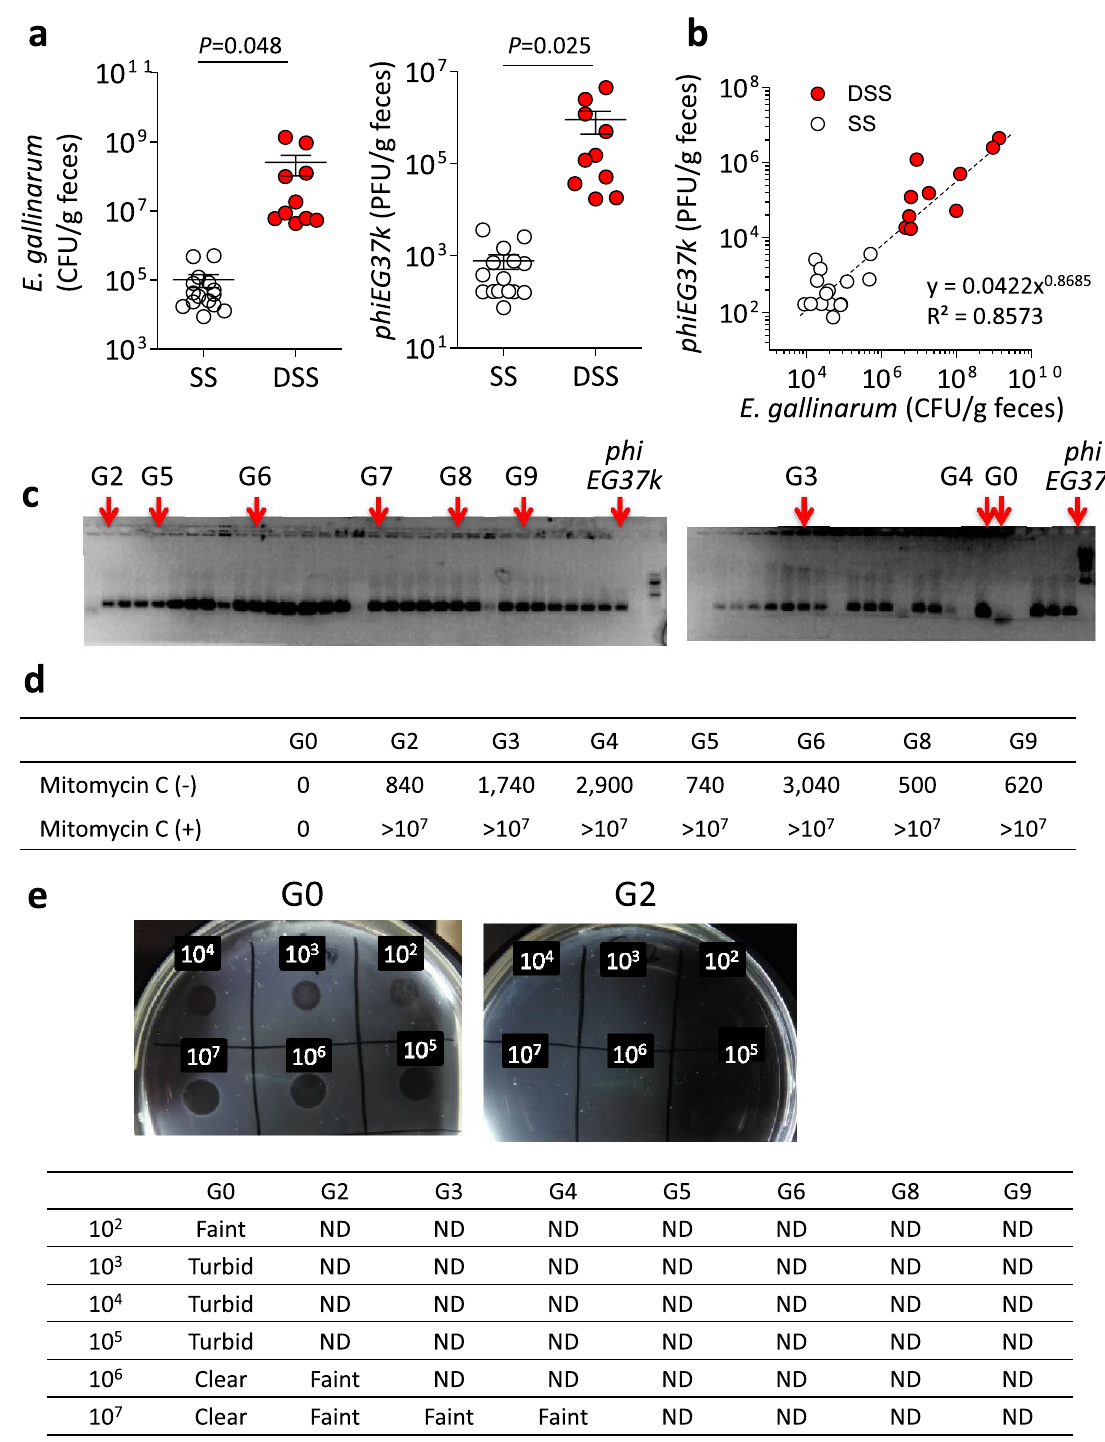
Figure 2. Most phiEG37k phages exist in lysogenic cycle in the colonic ecosystem in SPF C57BL/6 mice. The characterization of the interaction of phiEG37k phage and host E. gallinarum in the gut ecosystem was investigated . ( a ) Titers of E. gallinarum (left panel) and phiEG37k (right panel) in feces in steady state (SS) or DSS colitis (DSS). ( b ) Correlation curve of E. gallinarum titer versus phiEG37k titer in feces. n = 10. ( c ) PCR analyses of picked colonies of E. gallinarum isolated from feces of C57BL/6 mice in steady state by phiEG37k - specific primer. ( d ) Titer of phiEG37k phage particles in supernatant of individual cultures of different E. gallinarum colonies in c in the absence or presence of mitomycin C. ( e ) Spot assays of phiEG37k against individual clones in ( d ). ND; not detected. Two-tailed unpaired t-test P values are